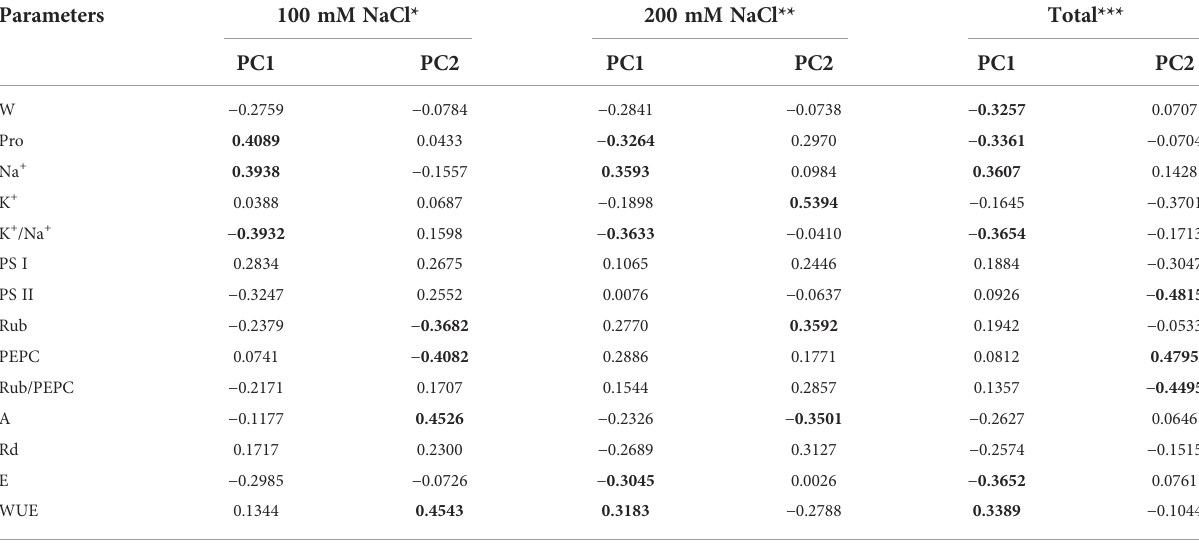
*Factor loading of parameters on axes 1 and 2 of PCA on Figure 6, **Factor loading of parameters on axes 1 and 2 of PCA on Figure 7, ***Factor loading of parameters on axes 1 and 2 of PCA on Figure